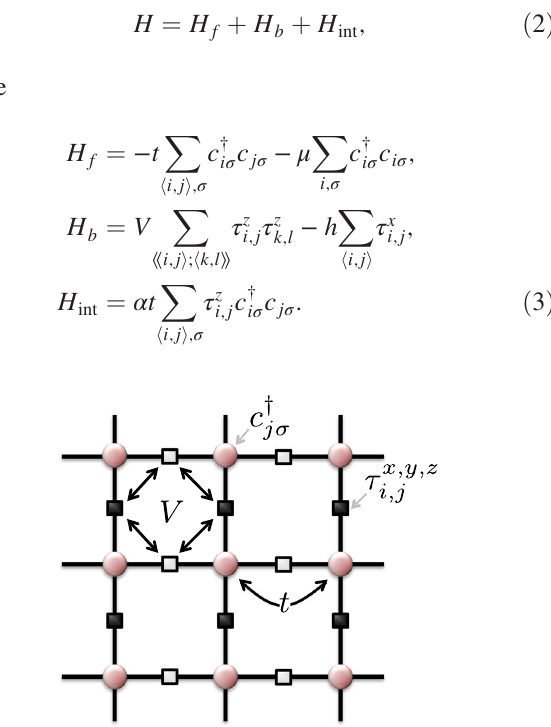
FIG. 3. Illustration of the lattice model Eq. (2). Spinful electrons reside on the sites, while the Ising pseudospins live on the bonds. The pseudospins interact with their neighbors antiferromagnetically, and are coupled to the fermion bond